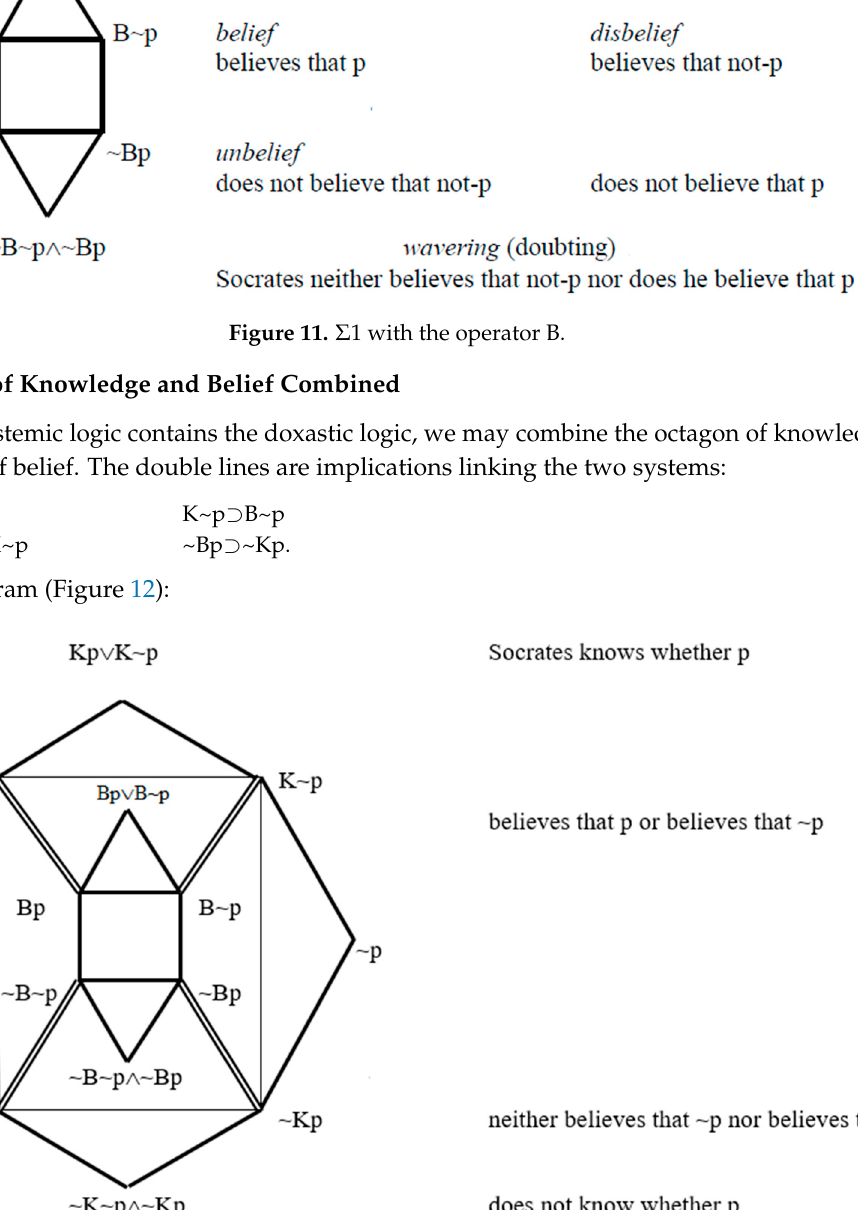
Figure 12. T he octagon of knowledge with the hexagon of belief combined.